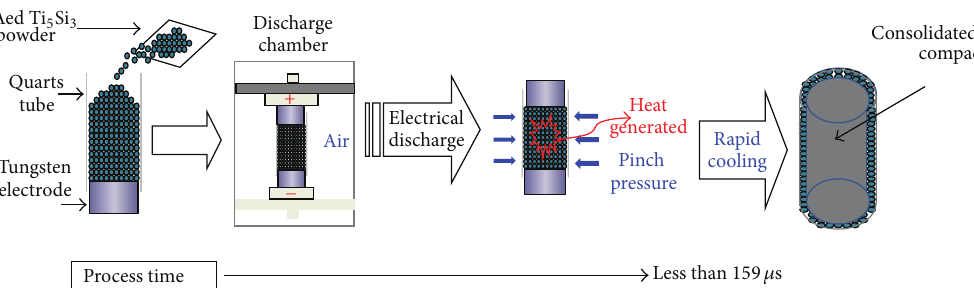
Figure 11: Schematic illustration for the formation of nanostructured Ti 5 Si 3 compact by an electrical discharge of MAed Ti 5 Si 3 powder.